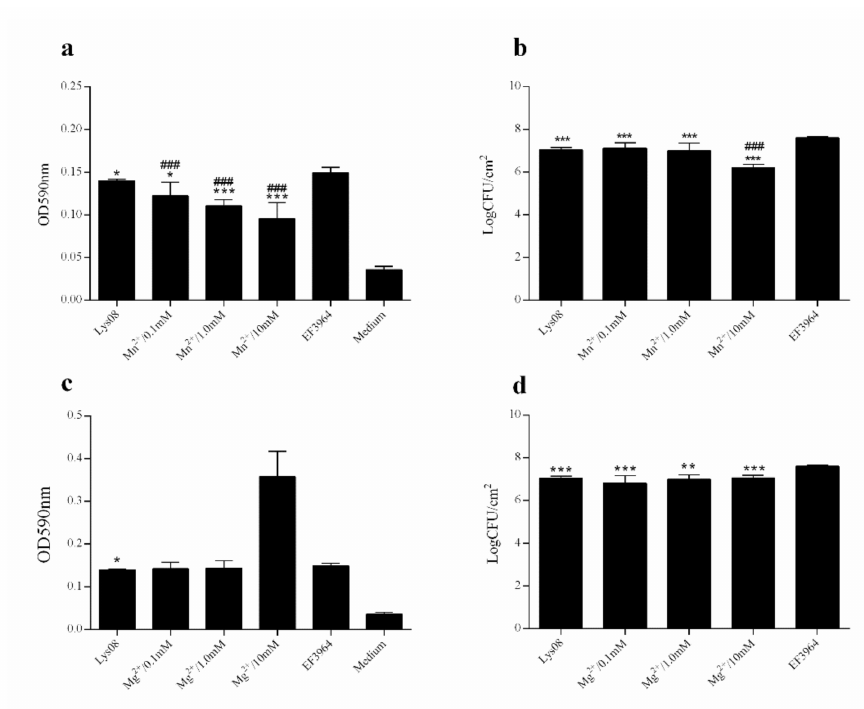
Figure 5. E ff ects of divalent ions on the activity of endolysin lys08. ( a , c ) OD 590 values of wells following treatment of E. faecalis EF3964 biofilms with endolysin lys08 plus various concentrations of Mn 2 + or Mg 2 + ions. ( b , d ) Viable cell counts following treatment of E. faecalis EF3964 with endolysin lys08 plus various concentrations of Mn 2 + or Mg 2 + ions. Significant di ff erences between the lys08-treated and untreated (EF3964) groups were determined by ANOVA (* p < 0.05, ** p < 0.01, and *** p < 0.001). For the comparisons between the lys08 plus ions treatment groups and the lys08-treated groups, significance is indicated by ### p < 0.001. Data are expressed as means ± SD from three independent experimental replicates ( n =